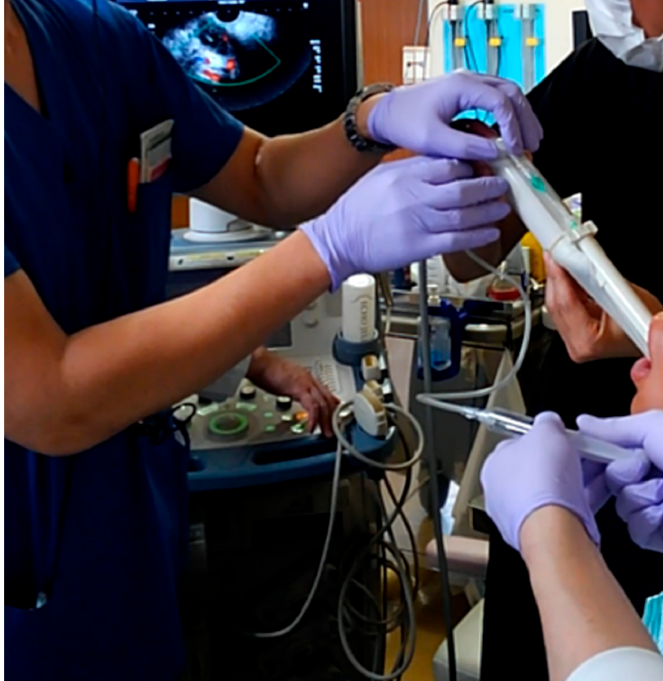
Figure 3. Puncture drainage by transoral pharyngeal ultrasonography (TOPU). Three doctors are performing the puncture drainage with TOPU. The doctor in the right upper side of the image is a neurologist, and he is operating the probe. The doctor on the left side of the image is an otolaryngologist, and he is inserting the needle into the pharynx under ultrasound imaging guidance. Another otolaryngologist is on the right lower side of the image, and he is aspirating pus with the 5-cc